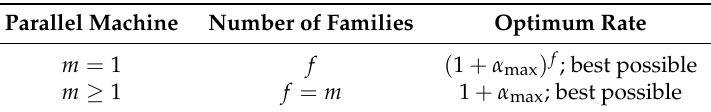
Table 3. Summary of